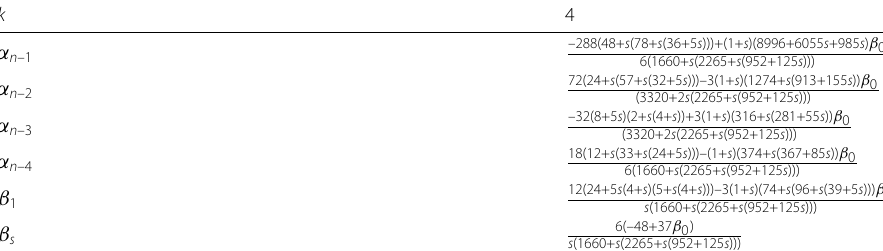
Table 2 The coefficients of method (2.2) for order 5